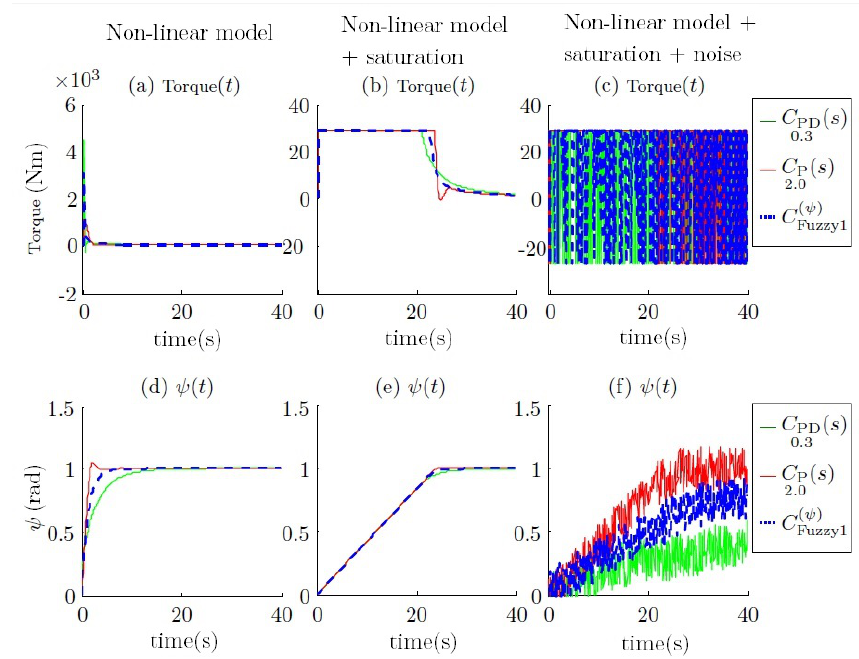
Figure 15. Torque comparison of the step response for the yaw using different controllers when the vehicle is navigating at 1 m/s. Subplots ( a , d ) represent the torque and yaw response without constraints. Subplots ( b , e ) show the response with physical constraints. Finally, subplots ( c , f ) show the response with physical and noise constraints.